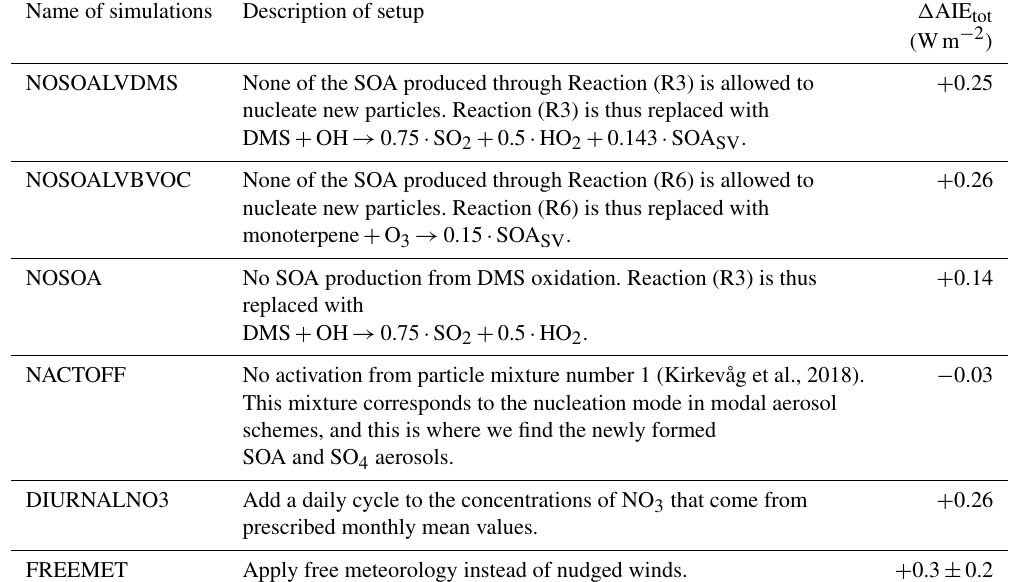
Table 7. Information about how the setup for the sensitivity tests deviates from the default original setup. The right column shows how the total aerosol indirect effect changes when switching from PD to PI oxidants in the PI simulation. (cid:49) AIE tot with the default model setup was + 0.25Wm − 2 .